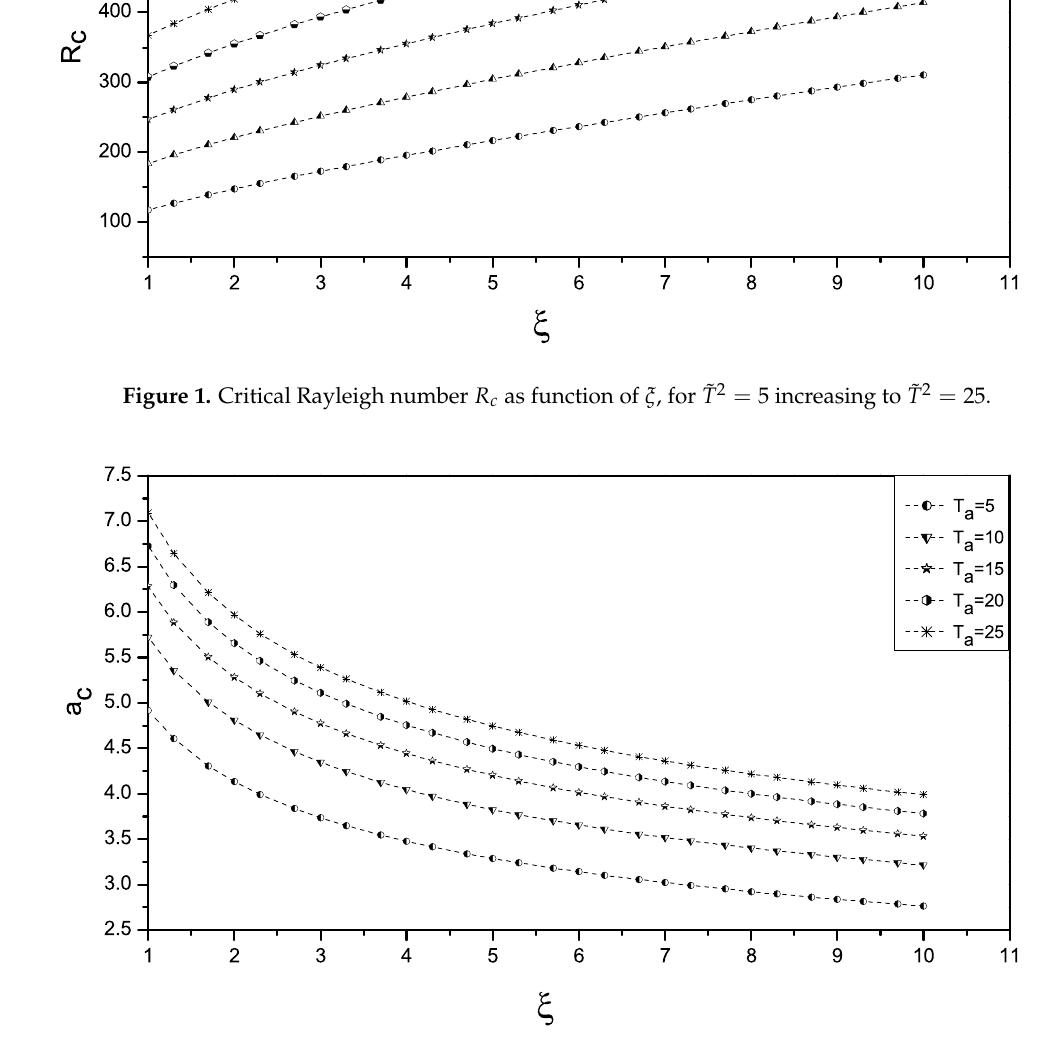
Figure 2. Critical wave number a c as function of ξ , for ˜ T 2 = 5 increasing to ˜ T 2 =